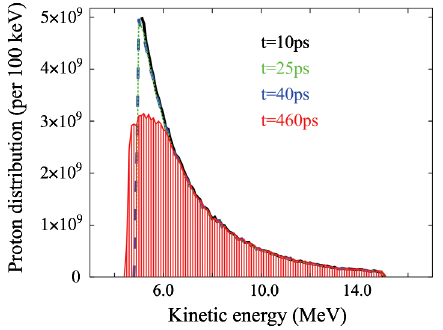
FIG. 16. Proton spectral distribution development within the first 460 ps. The shape is changing mainly at the low energy end.